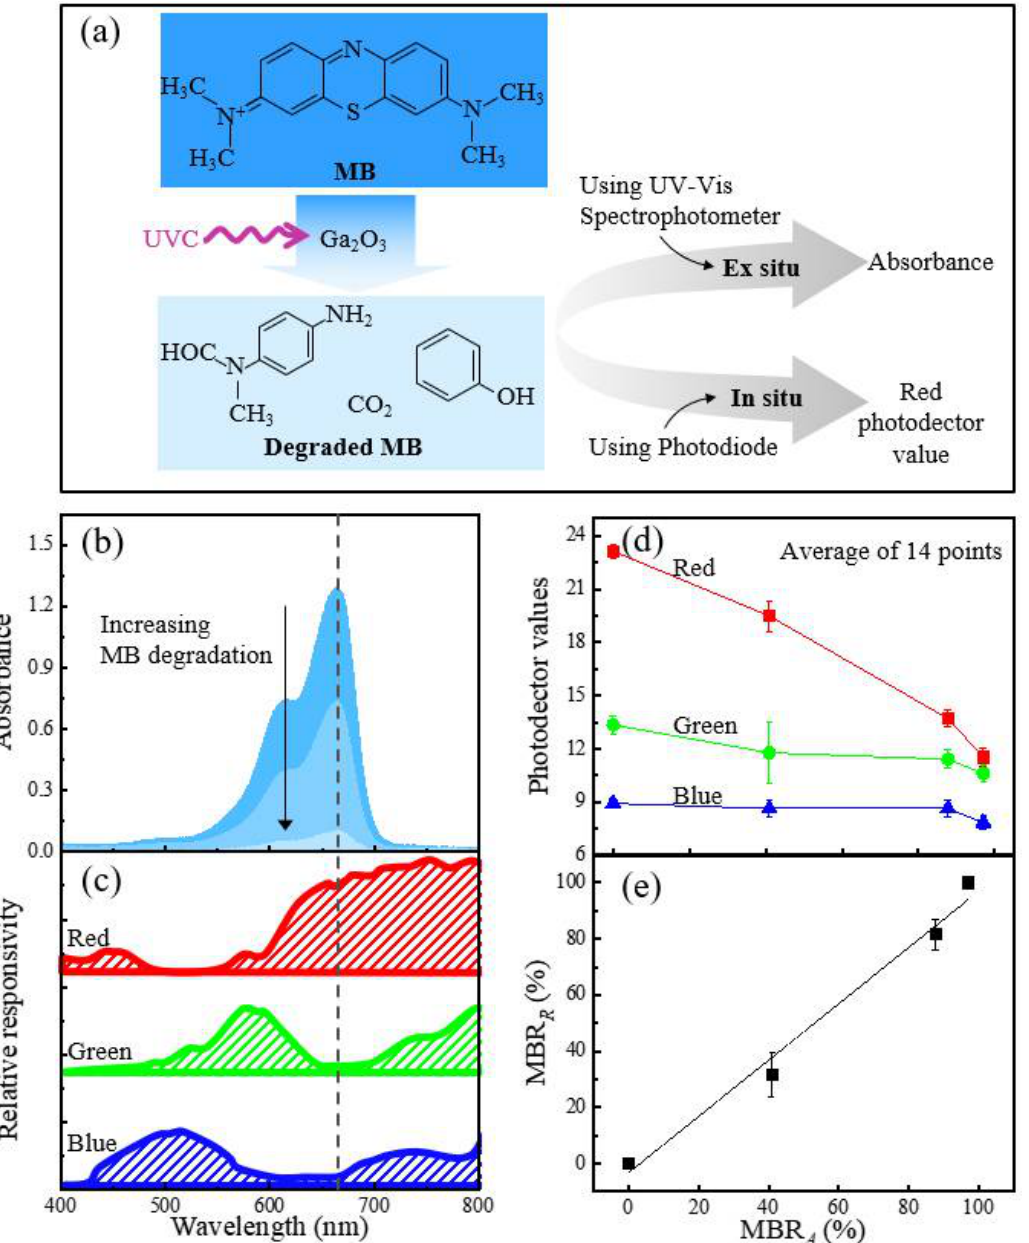
Figure 1. ( a ) Two different experimental setups for the ultraviolet-C (UVC) detection using methylene blue (MB) solution as a model system: MB reduction rates were quantified using either the ex situ absorption values from the UV-Vis spectrophotometer (MBR A ) or the in situ R value from the RGB photodetector (MBR R ). ( b ) Absorption spectra of the MB reduction with Ga 2 O 3 photocatalysts at different UVC irradiation times. ( c ) The relative responsivity of the red ( R ), green ( G ), and blue ( B ) values in the range of 400 to 800 nm from the RGB photodetector datasheet [18]. ( d ) Extracted R , G , and B values from the RGB photodetector as a function of the MBR A values while the sample was under UVC illumination; the R , G , and B values were proportional to the given area of the R , G , and B relative responsivity, respectively, as seen in Figure 1c. ( e ) The correlation diagram between MBR A and MBR R . The average value along with the standard deviation for each point of the MBR R measurements was acquired using 14 different points.